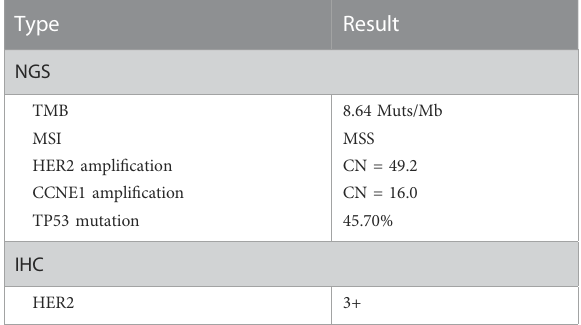
TABLE 1 Gene alterations in live